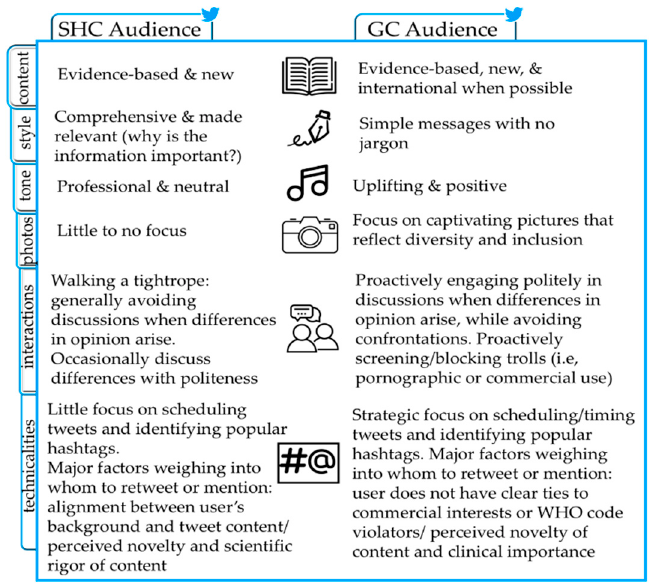
Figure 4. Summary of influencers’ communication strategies by type of audience. SHC, scientific health community. GC, general community. Images from top to bottom titled Book, Pen, Music, Camera, People, and Hashtag by Tippauan, Pictohaven, Iga, Yantianis, Farias, and Triyana, respectively, from the Noun Project.